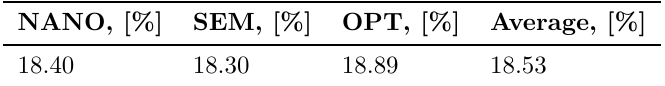
Table 2. Volume fractions of anhydrous clinker.